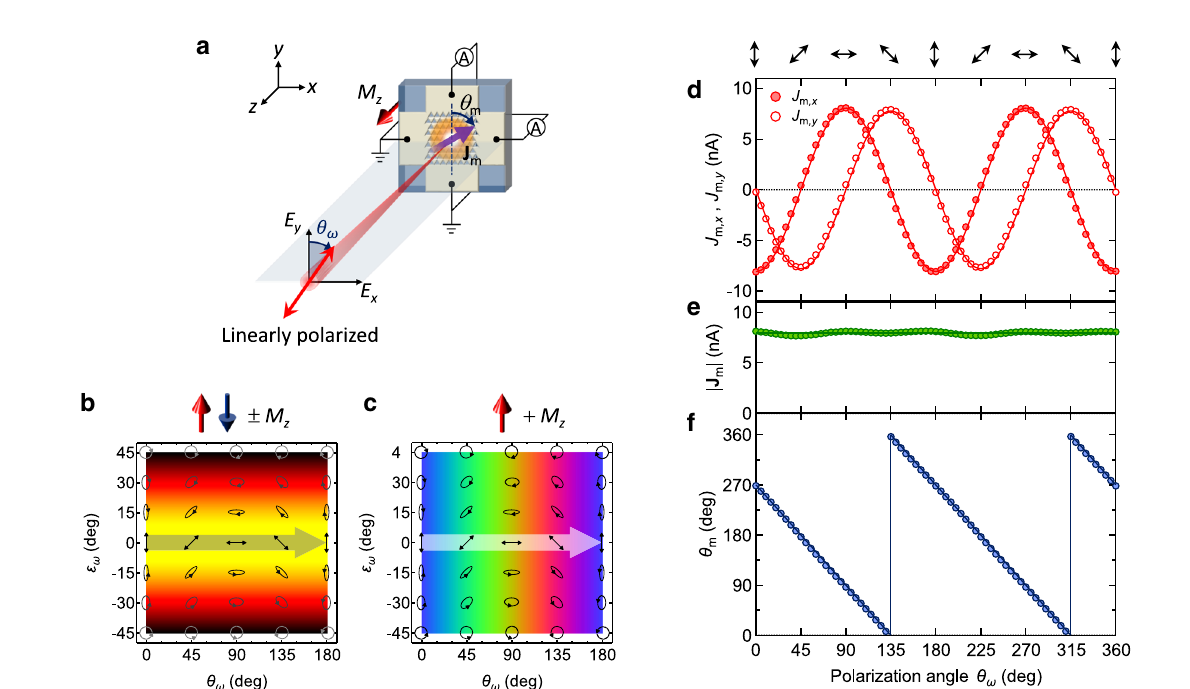
h i = 2,respectively,toexcludeconventional(nonmagnetic) J m, y = J y ð + M z Þ(cid:2) J y ð(cid:2) M z Þ photogalvanic effects (see Supplementary Figs. 3, 4, 6 and Supplementary Dis- cussion). The lines are fi tted to J m, x / (cid:2) cos2 θ ω and J m, y / (cid:2) sin2 θ ω . e ∣ J m ∣ calcu- q ffiffiffiffiffiffiffiffiffiffiffiffiffiffiffiffiffiffiffiffiffiffiffiffiffiffiffiffiffiffiffiffiffi ð J Þ 2 + ð J Þ 2 and ∣ ; J m ∣ =const : f θ m calculated as lated as ∣ ; J m ∣ = (cid:5) (cid:6) m, x m, y (cid:2) 1 J θ = J (blue circles) and fi tted to θ m = − 2 θ ω − 90° (blue lines). (cid:3) (cid:4) m =tan m, x m, y = 2 and